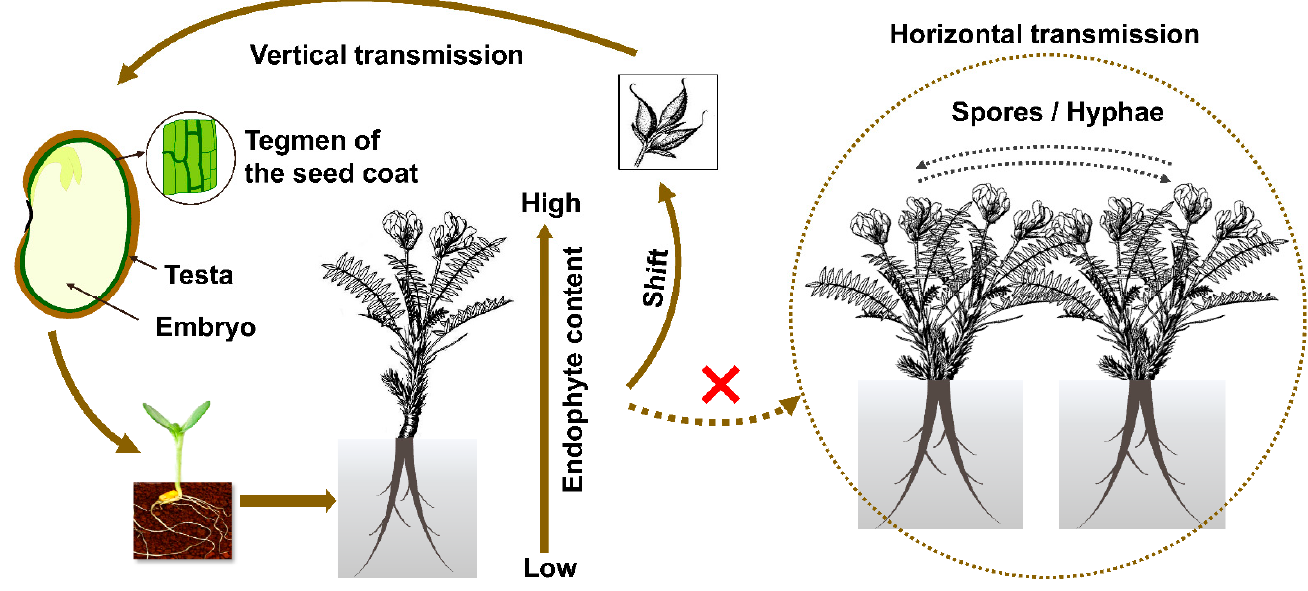
Figure 2. Model of transmission in Oxytropis locoweeds. Dotted line and the cross mark in red indicated horizontal transmission has not been found in the field for such symbiosis.